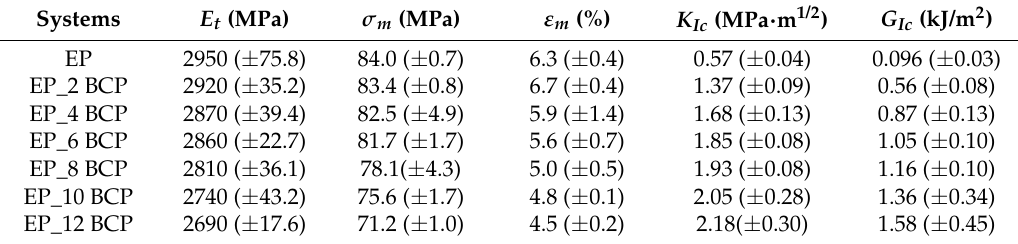
Table 3. Tensile and fracture mechanics properties of EP_BCP systems measured at 23 ◦ C.